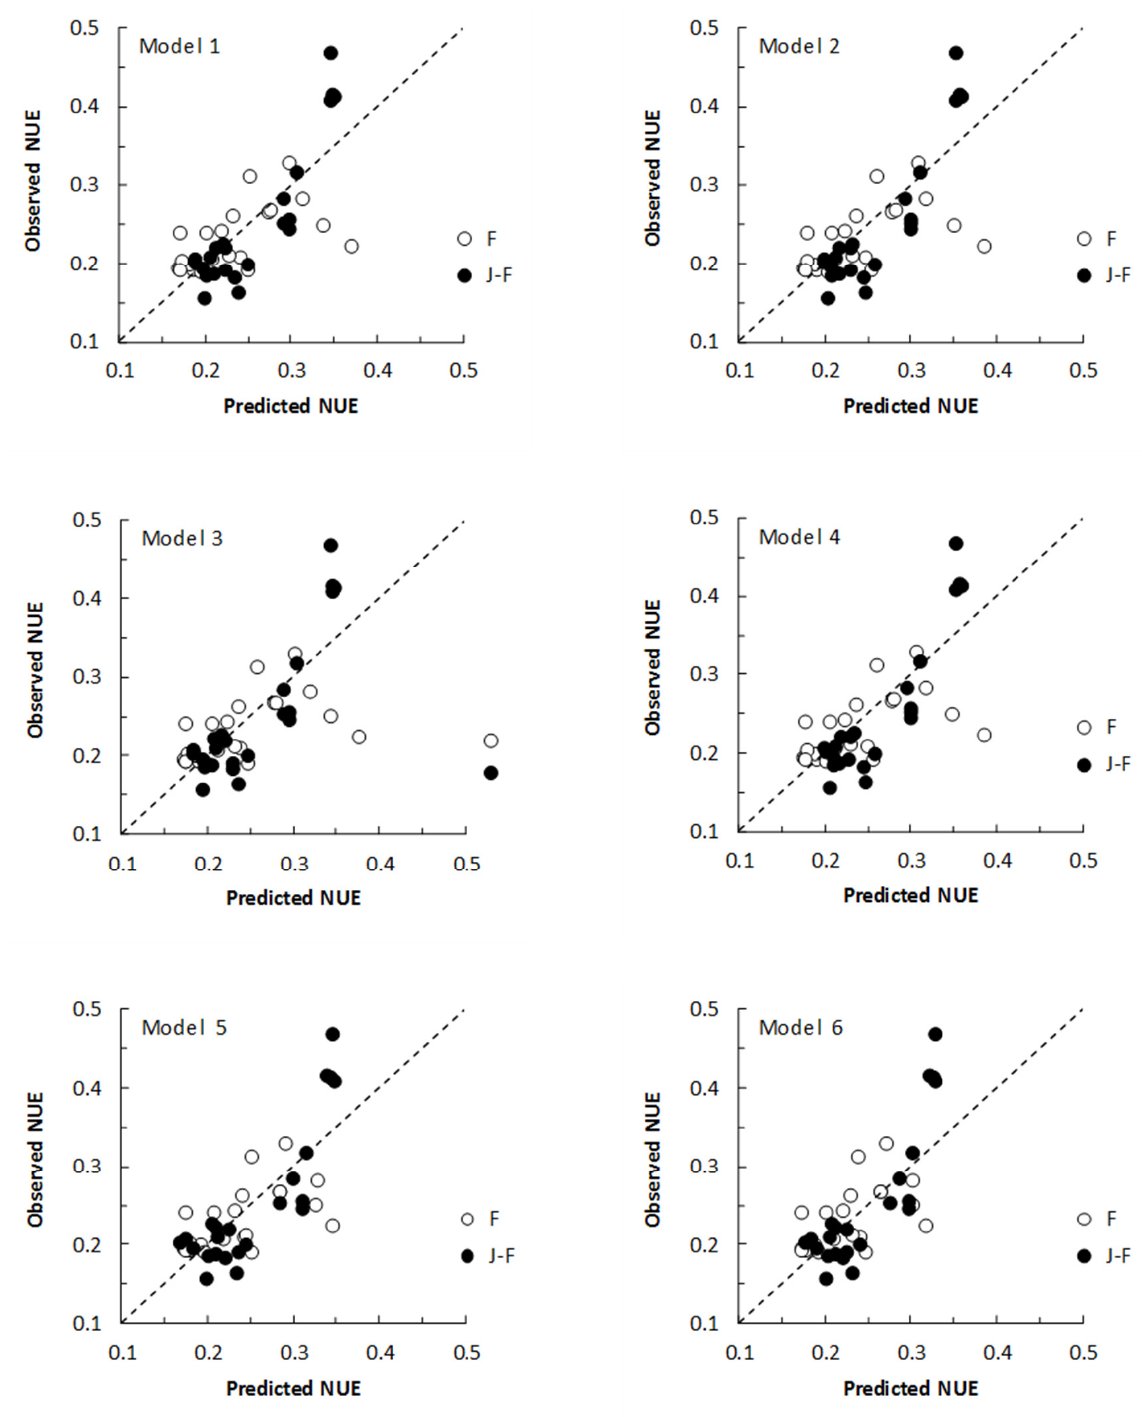
Figure 2. Plots of predicted NUE values vs. observed group NUE scores for Friesian and Jersey × Friesian cows from models 1–6 produced via all subset regression procedures (Table 5). The dotted line represents the line of the perfect fit. (N = 45; only those groups for which NUE, WS/CP, and MUN data were all available and have been included).